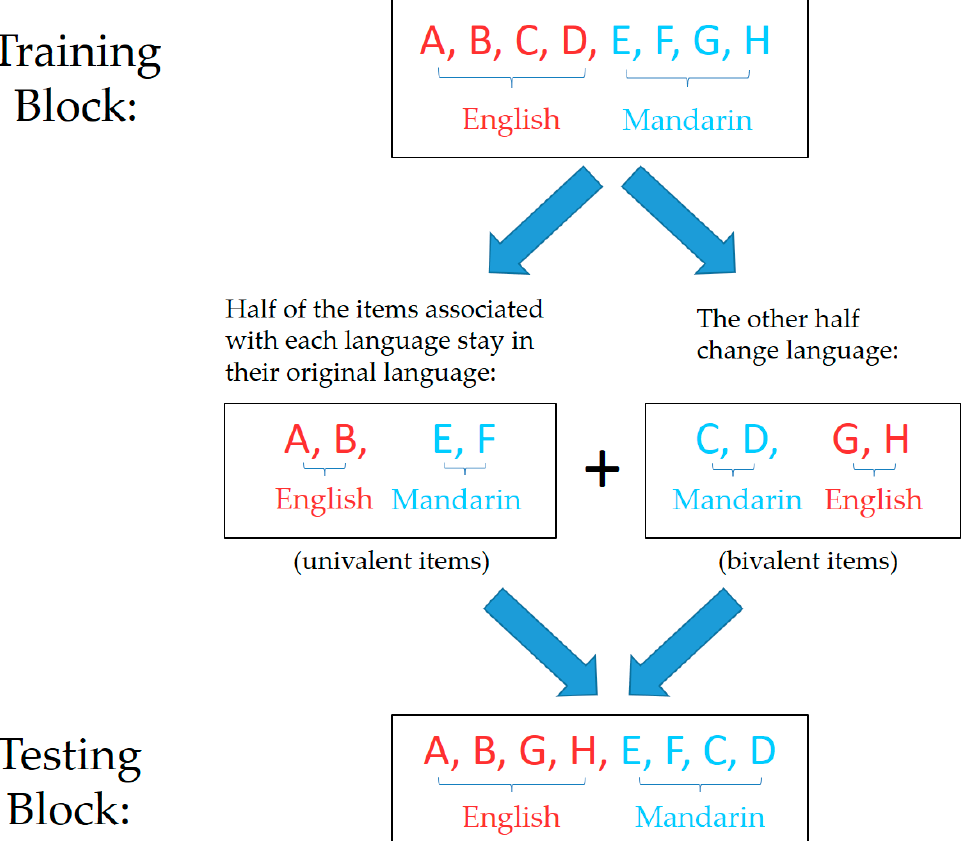
Figure 2. Illustration of the procedure used in Experiment 1 to achieve balanced assignments of language and valence to the picture stimuli. A total of eight pictures were used in this experiment. Here, each letter (e.g., “A”) represents one picture item. Items associated with English are shown in red; items associated with Mandarin are shown in blue. Univalent items maintained consistent language requirement in the two blocks, while bivalent items were trained and tested in opposite languages. Item–language pairings for the training block were randomly generated for each participant, such that four out of the eight pictures were associated with English and the other four with Mandarin ( top row ). Next, out of the four pictures associated with each language, two were randomly selected to be univalent and the other two were assigned to be bivalent. The language requirement for each bivalent item was changed ( middle row ). This produced the set of item–language associations to be used in the testing block ( bottom row